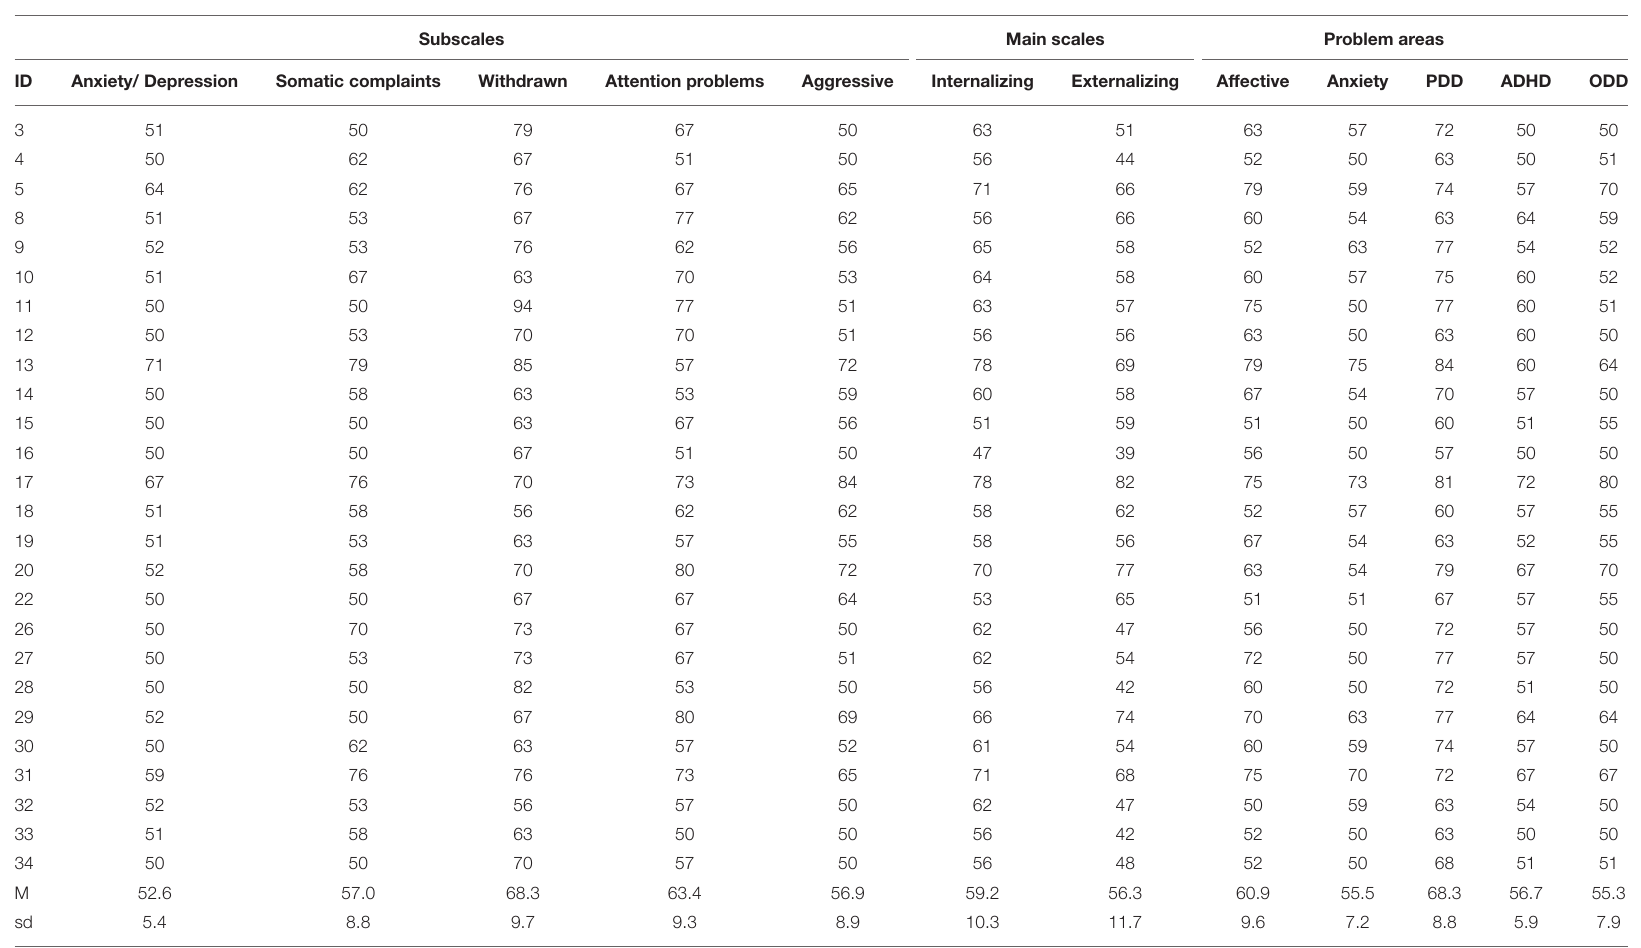
TABLE 3 | Scores on behavioral problems measured with Child Behavior Checklist